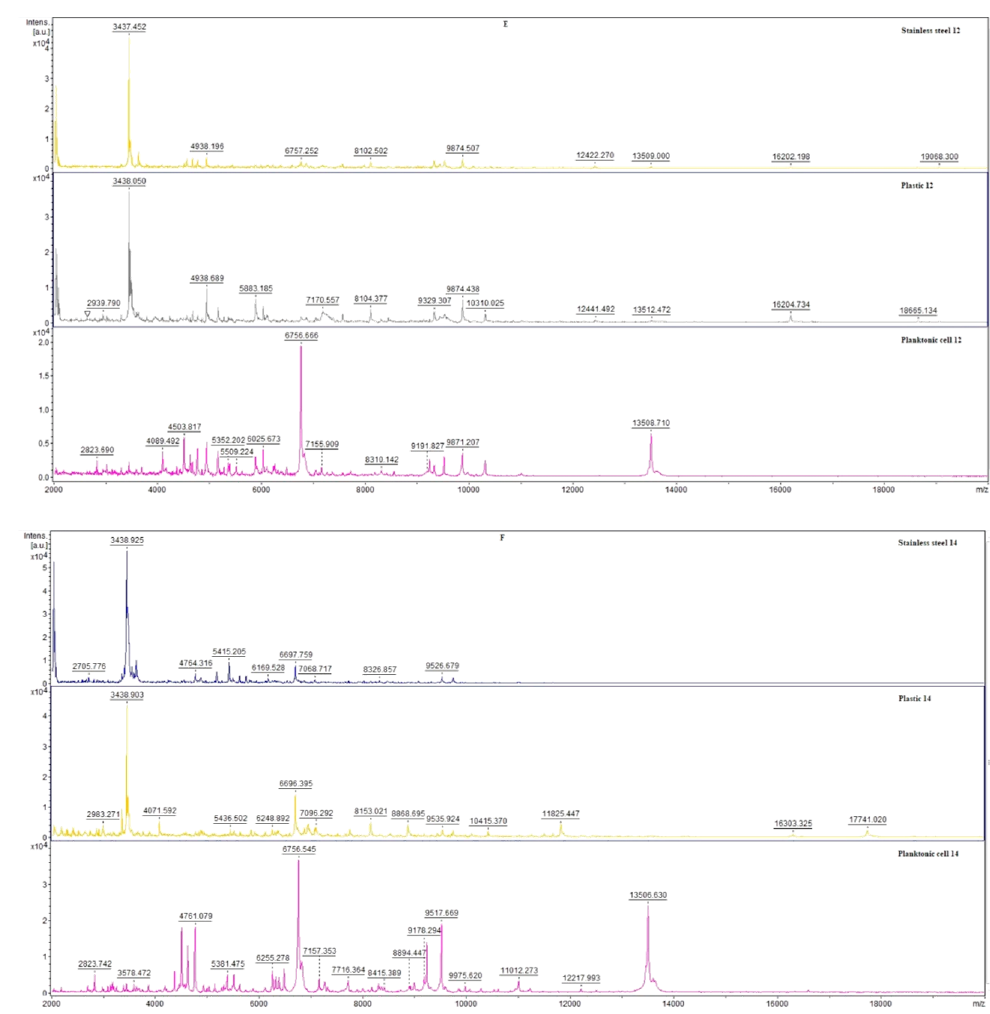
Figure 1. Representative MALDI-TOF mass spectra of S. enterica : ( A ) 3rd day, ( B ) 5th day, ( C ) 7th day, ( D ) 9th day, ( E ) 12th day, and ( F ) 14th day.